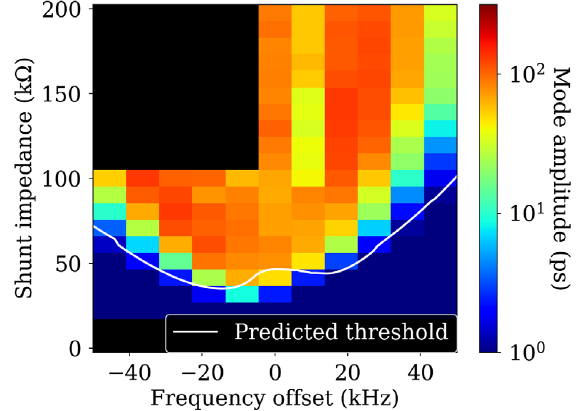
FIG. 8. Bunch motion observed in macroparticle tracking compared to the threshold shunt impedances predicted by theory including the effect of the bunch forms and lengths. The black pixels are points for which no simulation was run.